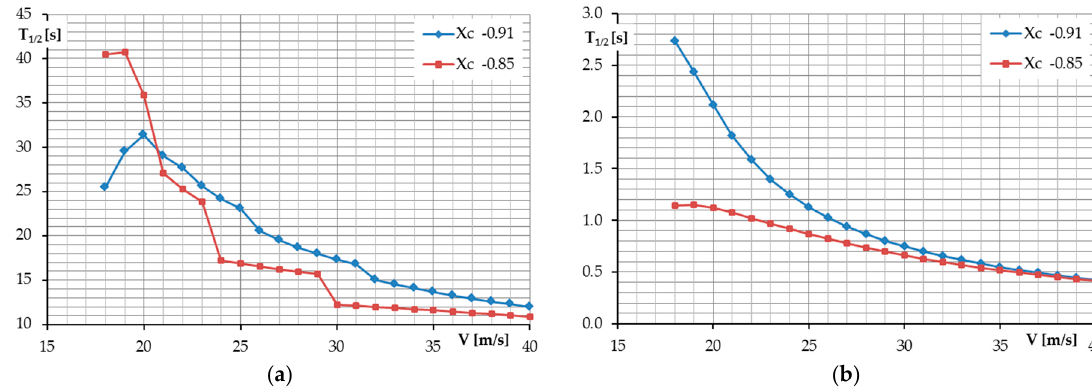
Figure 18. Dynamic stability characteristics of the airplane with the most aft CG and vertical stabilizer location. Time to halve the amplitude of the oscillations: ( a ) phugoid motion; and ( b ) Dutch roll motion.